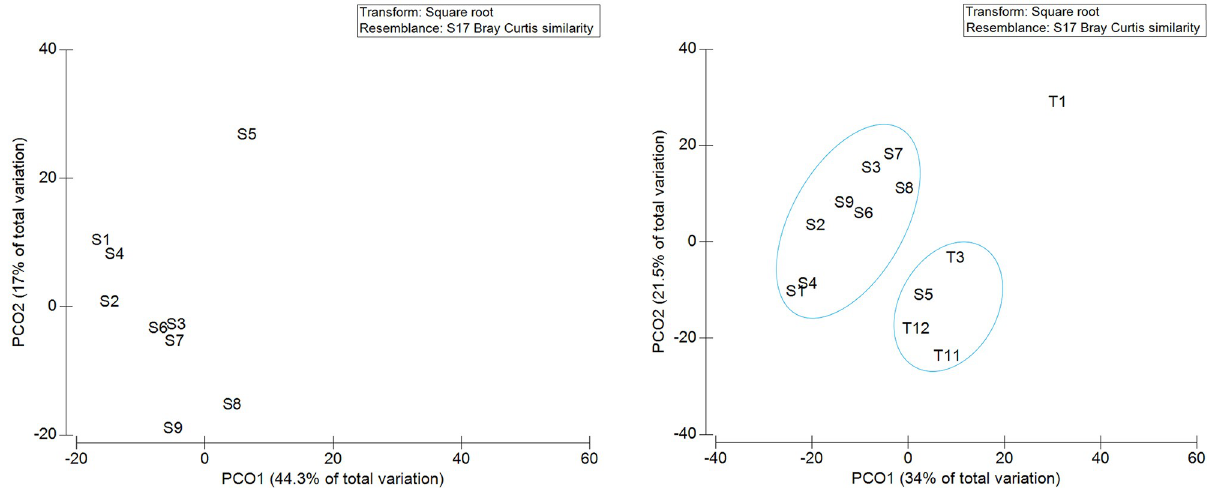
Fig 2. Principle coordinate analysis (PCoA) plot of S samples of this study (A) and S+T samples (B). S and T indicate samples obtained from this study and from Abdelrhman et al . 23 , respectively.